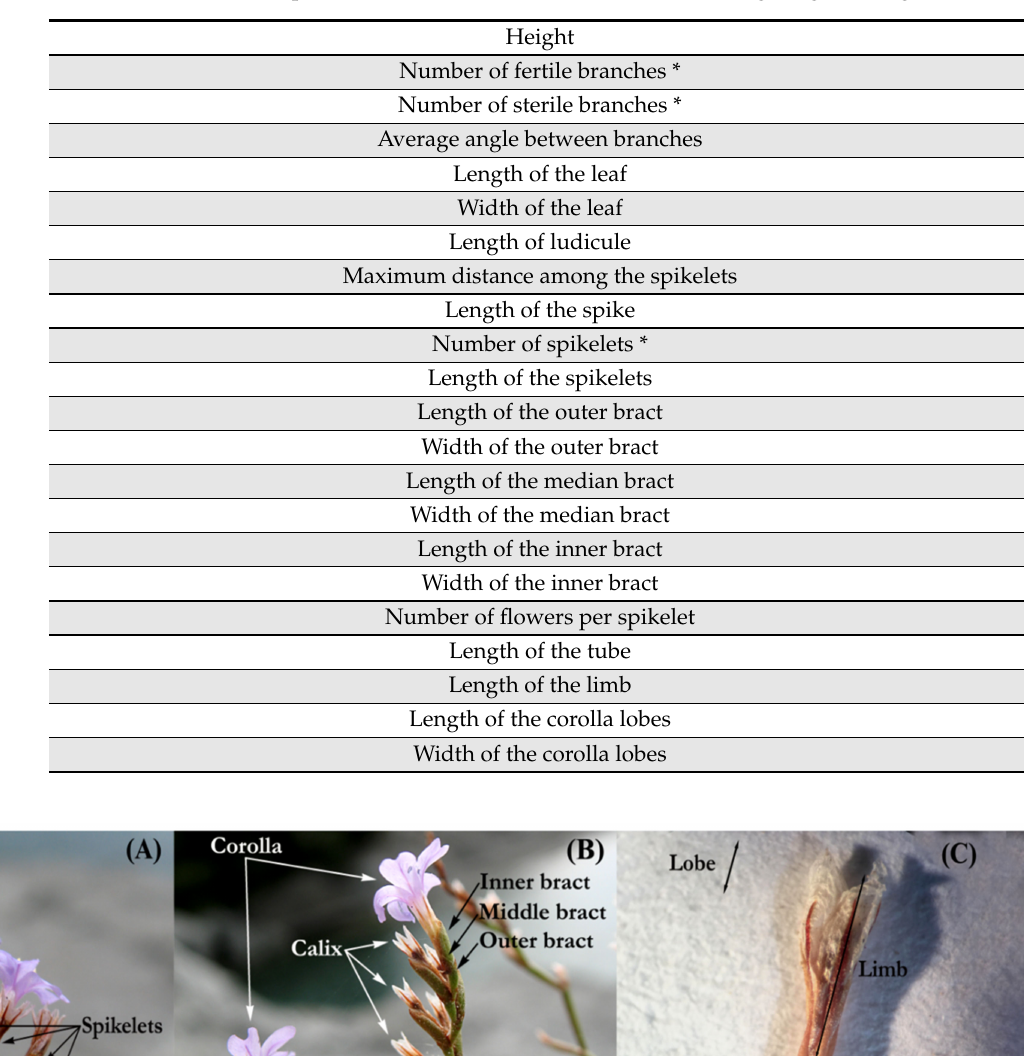
Table 4. Morphological characters measured. Qualitative characters are marked with an asterisk (*); the other characters are quantitative (units in millimeters and, for average angle, in degrees).